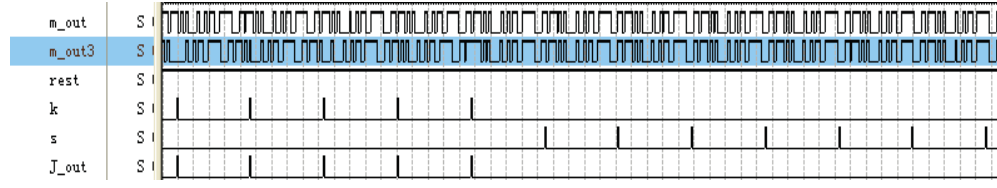
Figure 28. Timing simulation of the code acquisition module.